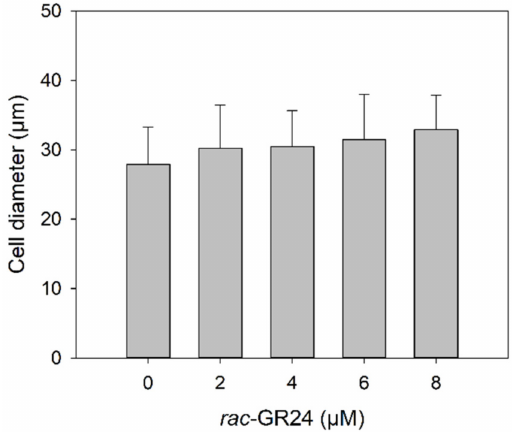
Figure 3. Cell diameter of H. pluvialis after 30-d photosynthetic cultivation at different rac -GR24 con- centrations (2.0–8.0 µ M). Over 200 algal cells at each concentration were measured under light